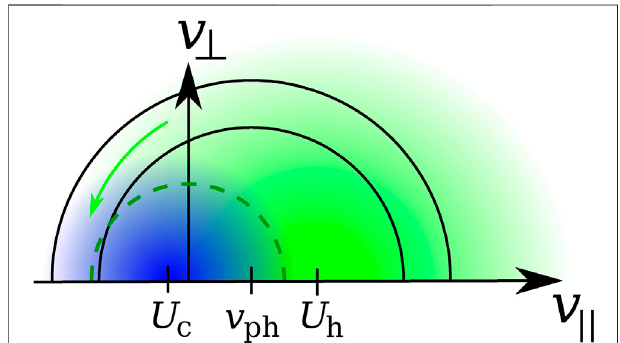
FIGURE 9 | Schematic illustration of the quasi-linear diffusion in the whistler heat- fl ux instability. The blue shaded area represents the core electron population with bulk velocity U c , and the green shaded area represents the halo population with bulk velocity U h . The black semi- circles represent Eq. 17 for parallel-propagating fast-magnetosonic/whistler waves with parallel phase speed v ph . The diffusive fl ux of cyclotron-resonant particlesisshownbythegreenarrow.Thegreen-dashedsemi-circleindicates v 2 ⊥ + v 2 (cid:2) (cid:3)